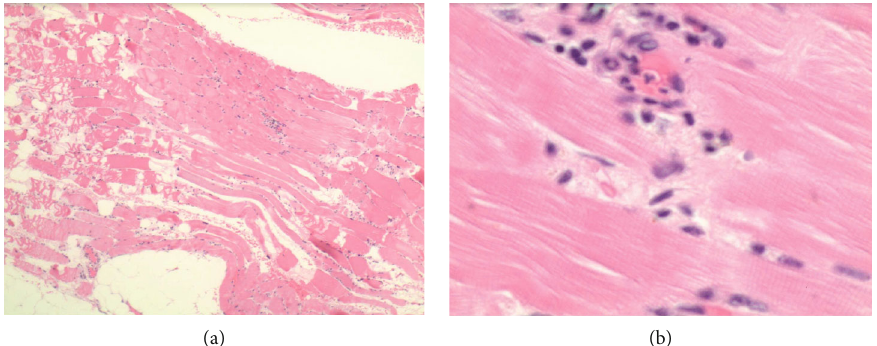
Figure 7: Cardiac biopsy on low power (a) and high power 40x (b). Findings: Lymphocytic in fi ltration into cardiac muscle, suggestive of